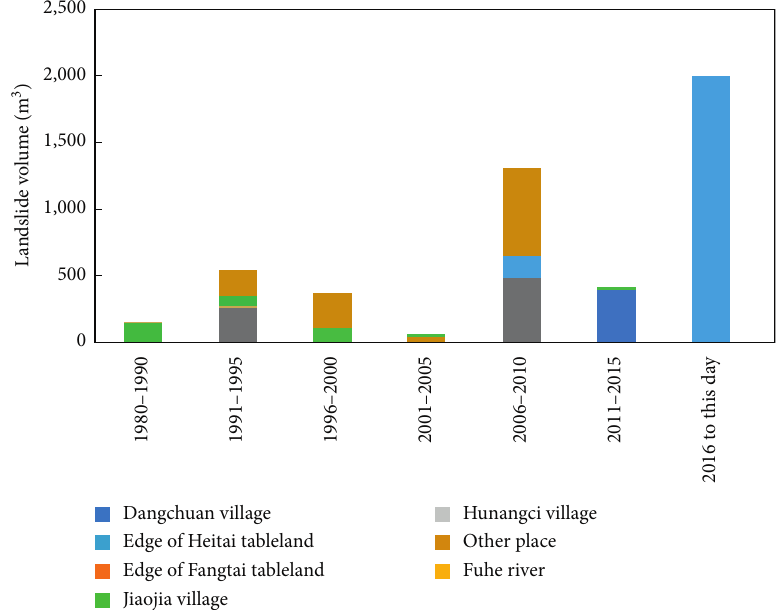
Figure 6: Loess landslide statistics of Heifangtai tableland from 1980 to now.